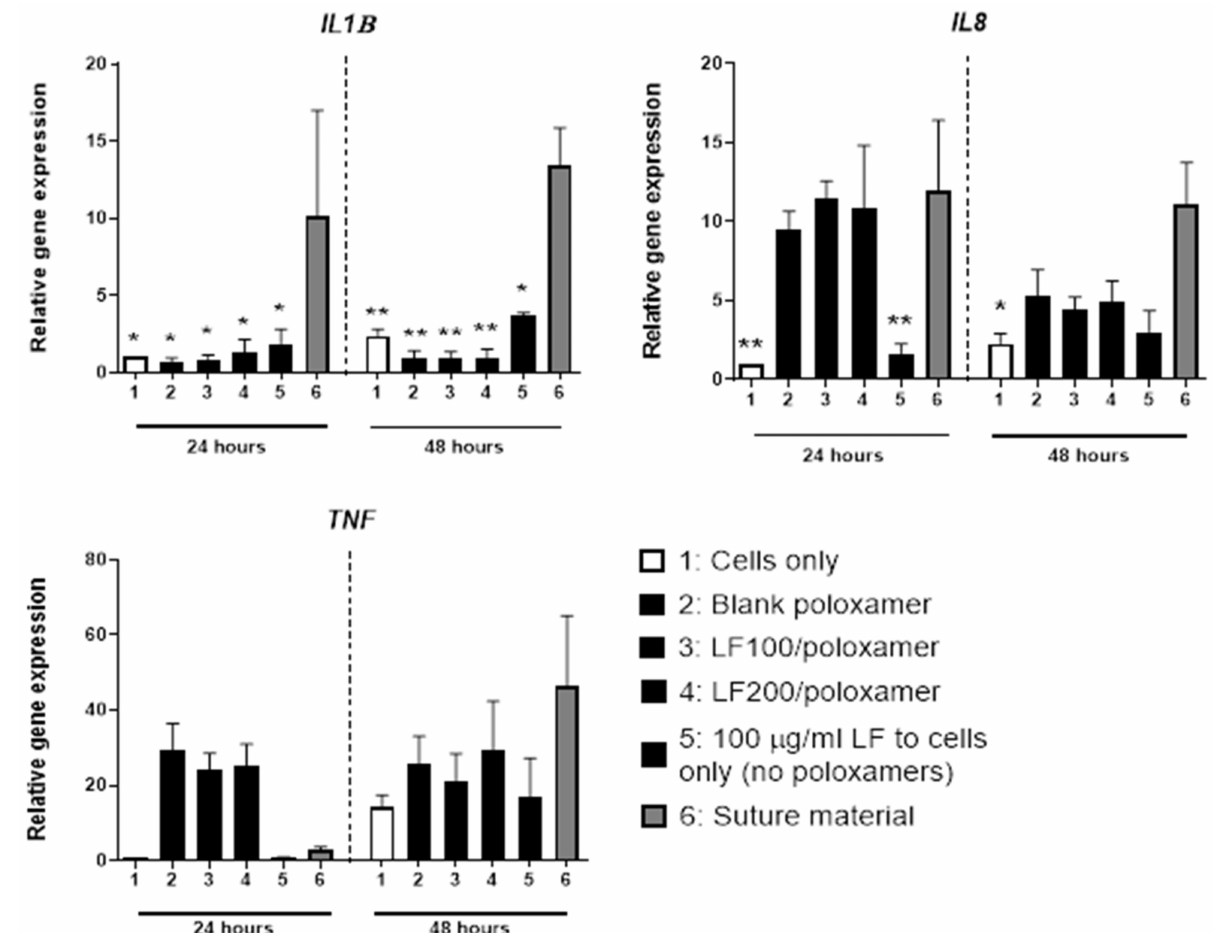
Figure 4. The expression levels of genes encoding inflammatory cytokines in THP-1 cells treated with LF-loaded poloxamer gels. Representative proinflammatory cytokine markers were examined. The cells were cultured on 200- µ L poloxamers for 24 and 48 h. Results from three biological experiments were pooled. Data shown are the mean ± SEM; two-way ANOVA with post hoc Dunnett’s test versus suture materials at that time point; * p < 0.05 and ** p <